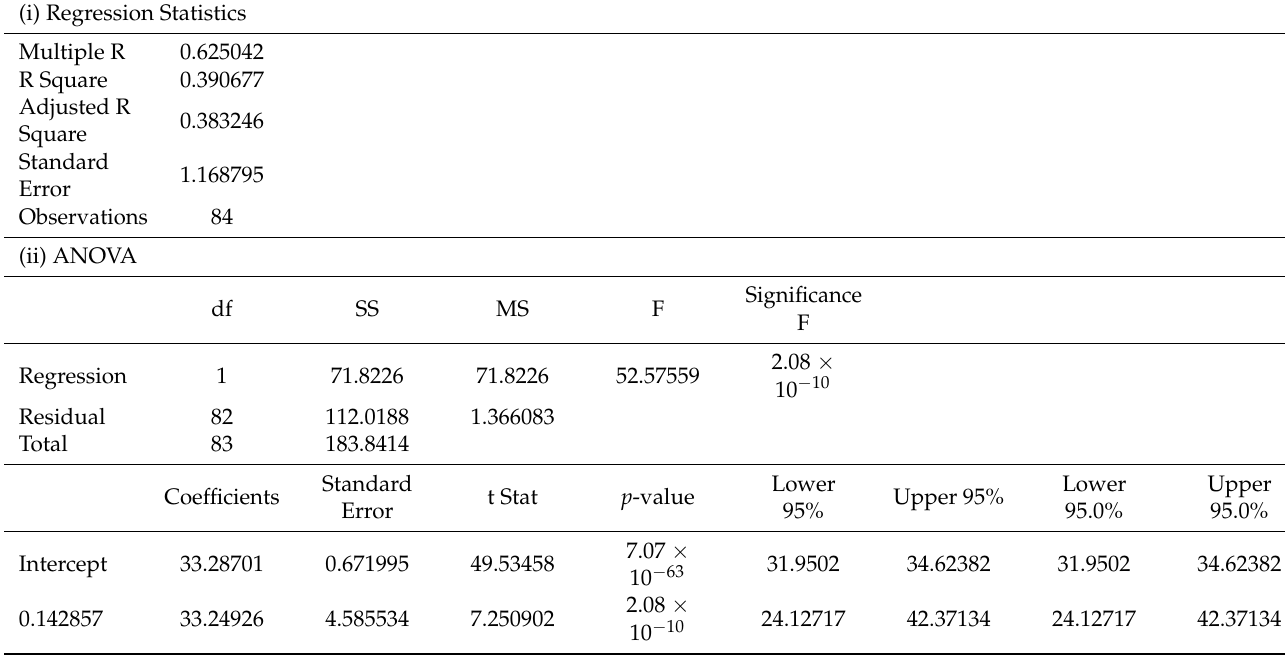
Table A8. Regression Statistics between LST and NDBI for